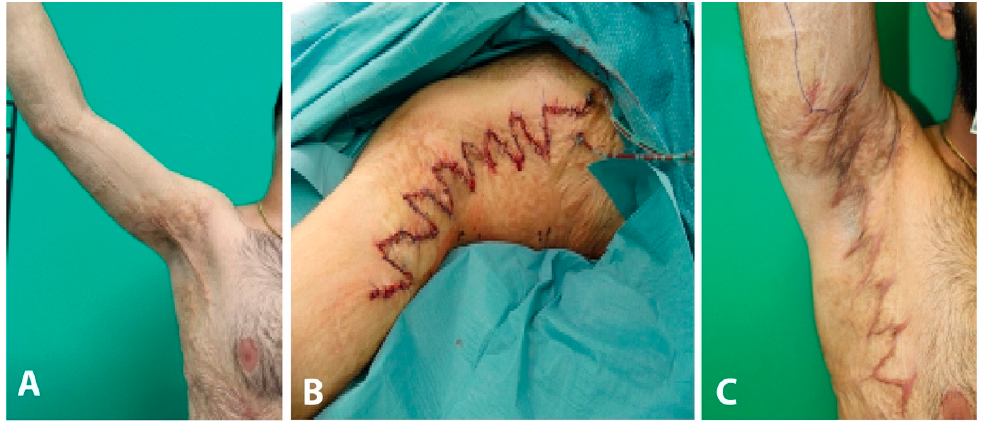
Figure 5. ( A )Preoperative hypertrophic scar with functional limitation of the arm, ( B ) Intraopera- tive picture after Z-plasty, ( C ) Postoperative outcome. picture after Z-plasty, ( C ) Postoperative